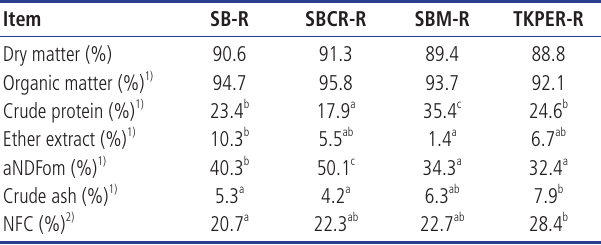
Table 2. Chemical composition of the experimental diets